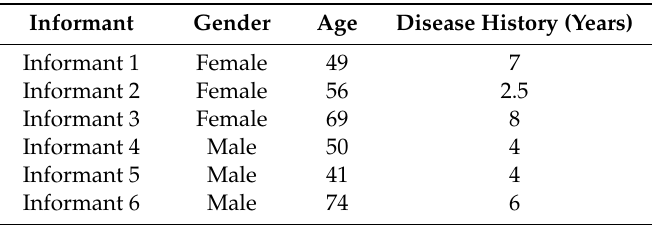
Table 2. Characteristics of